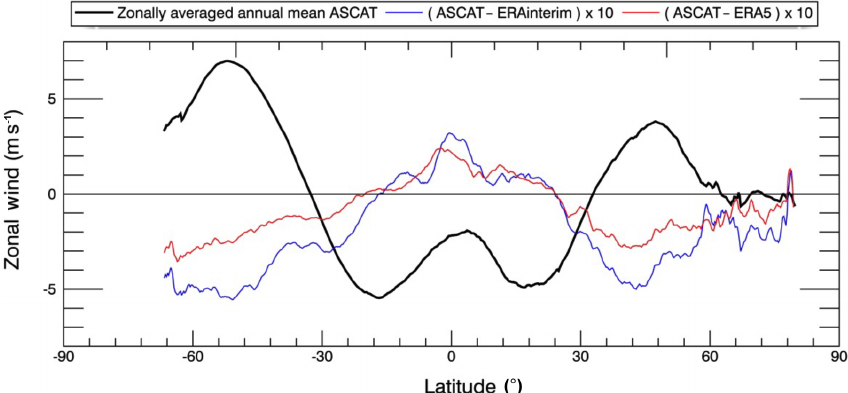
Figure 3. Zonally averaged annual mean zonal wind from ASCAT (thick black line) and differences with ERA-Interim (blue line) and ERA5 (red line) first-guess winds over 2016. Note that differences have been scaled by 10.